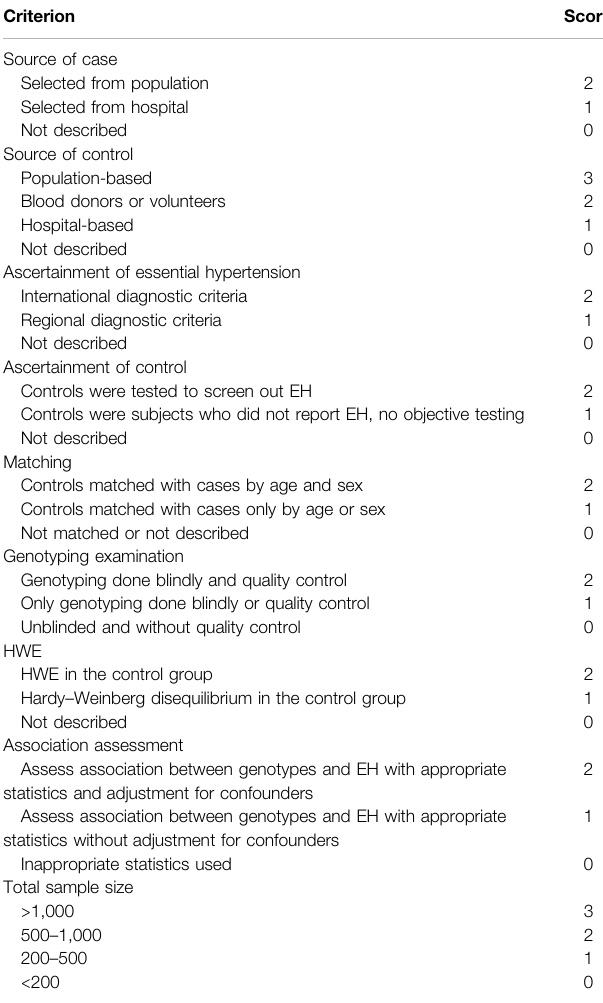
TABLE 1 | Scale for the quality assessment of molecular association studies of essential hypertension.